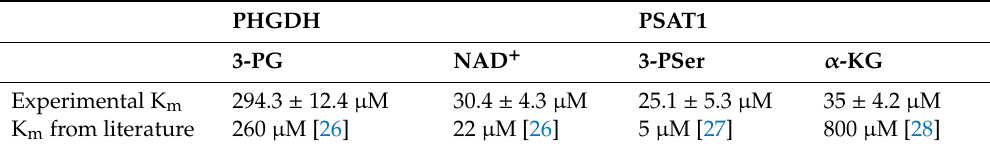
Table 1. Michaelis–Menten enzyme kinetics for PHGDH and PSAT1. All experiments were performed with at least triplicates and K m values were determined in two or more independent experiments.